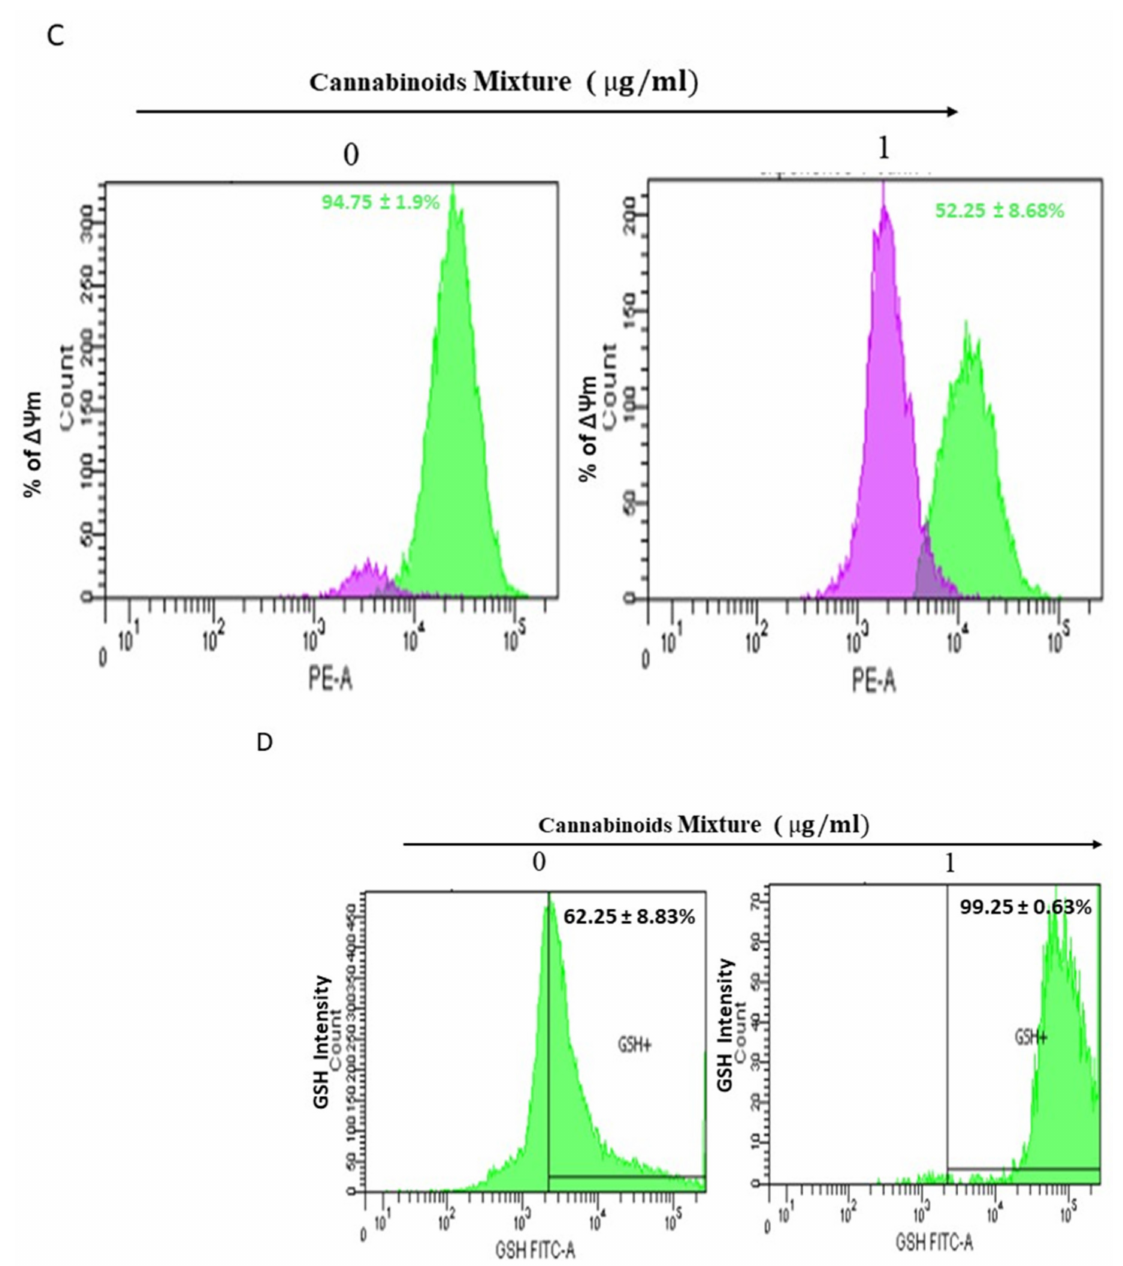
Figure 2. CM promotes oxidative stress and autophagy. ( A ) CM induces ROS expression in oral cancer cells. ROS levels were measured by flow cytometry using markers in the protocol ( n = 4). ( B ) Measurement of mitochondrial superoxide. Generation of mitochondrial ROS, in CM-treated and untreated Ca9-22 cells, was also assessed by this technique with MitoSOX staining, highly selective to detect superoxide in mitochondria from living cells. ( C ) Mitochondrial membrane potential was evaluated by flux cytometry using a MitoProbe TM DiOC2(3) Assay Kit from Thermo Fisher. Ca9-22 cells were treated with 1 µ g/mL of CM for 24 h. Next, 10 6 cells were loaded with 5 µ L of 10 6 µ M DiOC 2 (3) for 30 min at 37 ◦ C in the dark, before performing a flow cytometry analysis ( n = 4). ( D ) Cells were exposed to CM at 1 µ g/mL for 24 h and subjected to GSH staining, then analyzed by